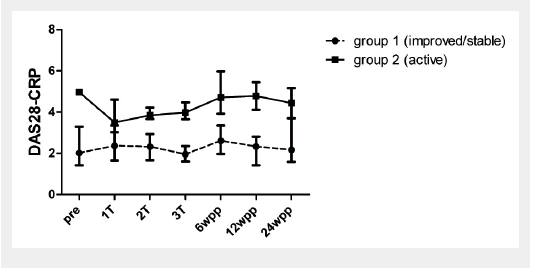
Disease activity of RA patients during and after pregnancy. Disease activity measured before (pre), once at each trimester (1T, 2T, 3T) and after pregnancy (6, 12 and 24 wpp: weeks postpartum) by the DAS28-CRP in 16 RA patients with low disease activity during pregnancy (group 1,dashed line) and in 6 RA patients with persistent active disease (group 2, black line). Values are medians with interquartile range.